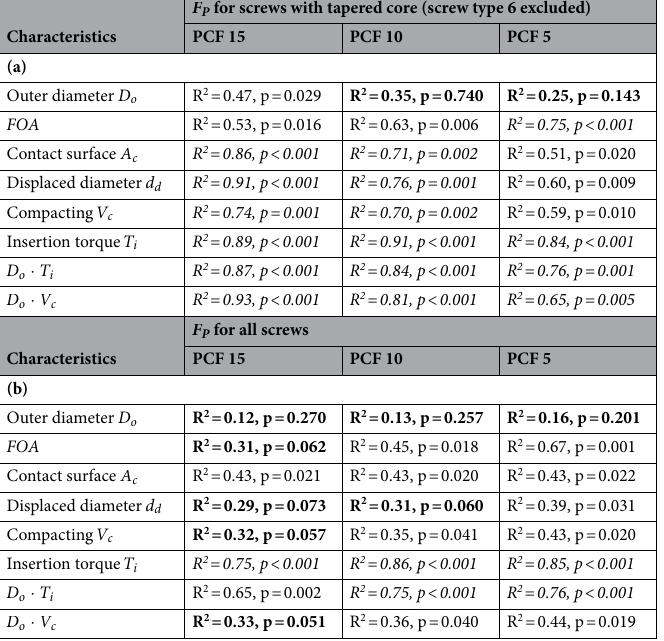
Table 3. Correlation results for different screw characteristics against pull-out strength for (a) screws with tapered core and (b) all screws considered. Data with high linear correlation are printed in italics, while non- significant data are shown in